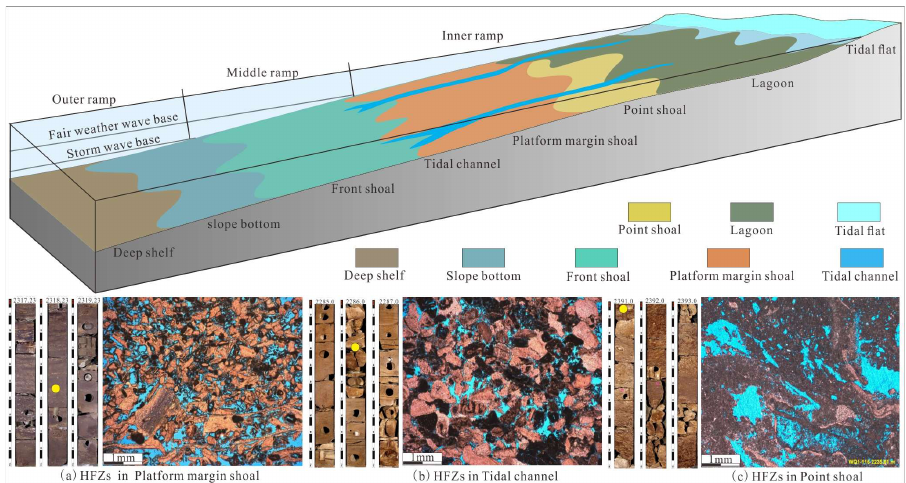
Figure 7. Depositional model and HFZs types in Mishrif Formation in X Oilfield.